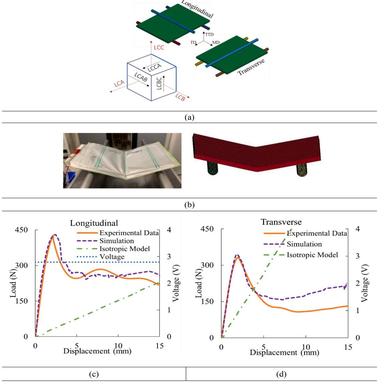
Three-point bending simulations. (a) Model setup and direction conventions for loading and the input curves of MAT_126 in Ls-Dyna (b) Deformed cell in the longitudinal direction, test, and simulation. (c) Comparison of load-displacement curves, experimental data, and simulations results in the longitudinal direction and d) transverse direction. The green dash-dotted lines in c and d show the prediction of the commonly used isotropic material model that fails to predict the behavior of the cells in bending.